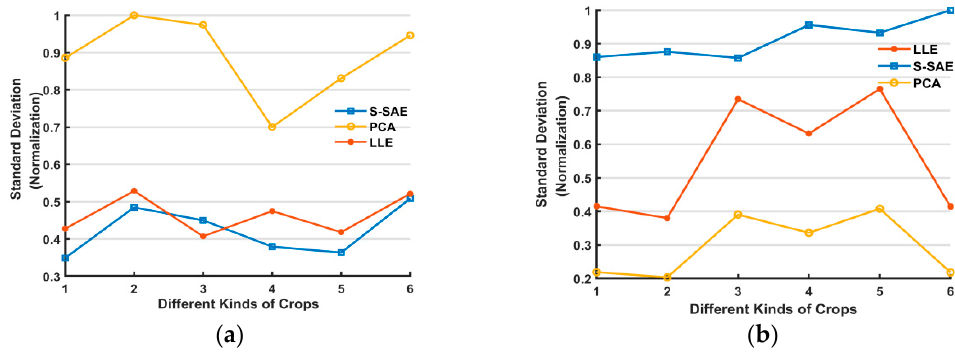
Figure 16. Values of standard deviation: ( a ) within the same class and ( b ) between different classes.